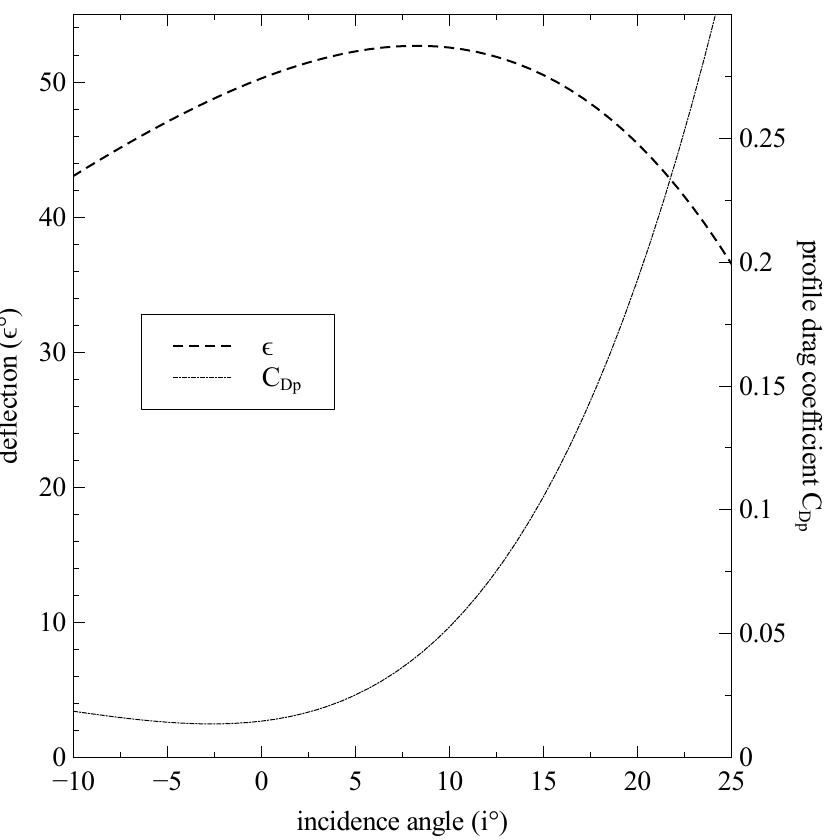
Figure 12. Off-design performance of the cascade, specific to the second stage of the Eck/Laing fan. Frequently, performance characteristics are appraised by assigning a value to the flow rate; however, by using the cascade principles, the flow rate is deduced by assigning